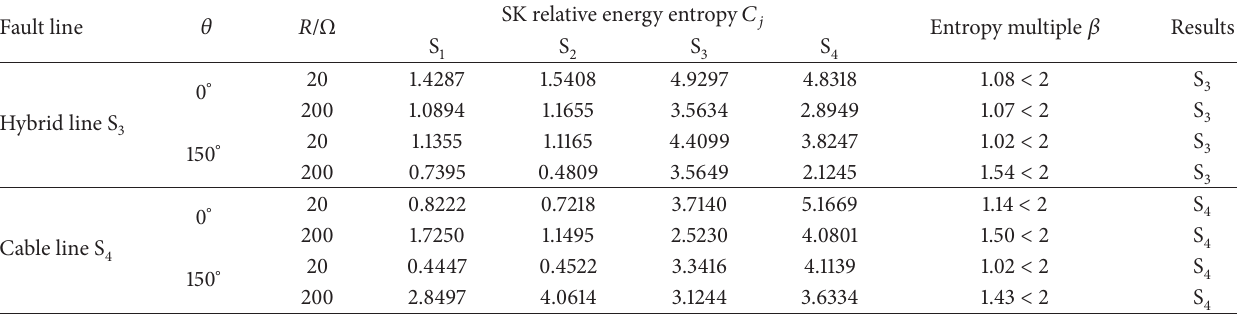
and S faults. 3 4